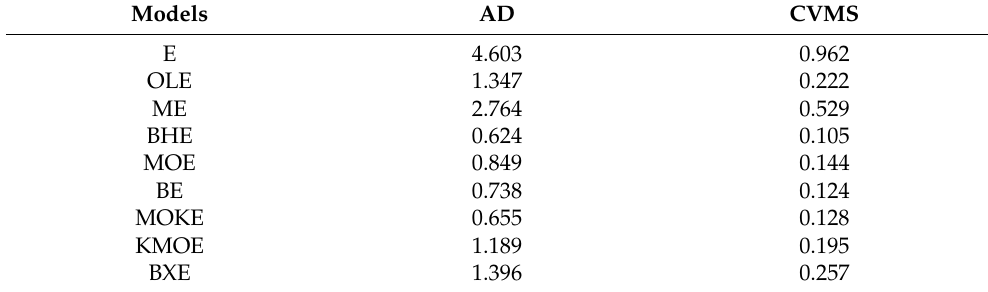
Table 7. AD and CVM for relief